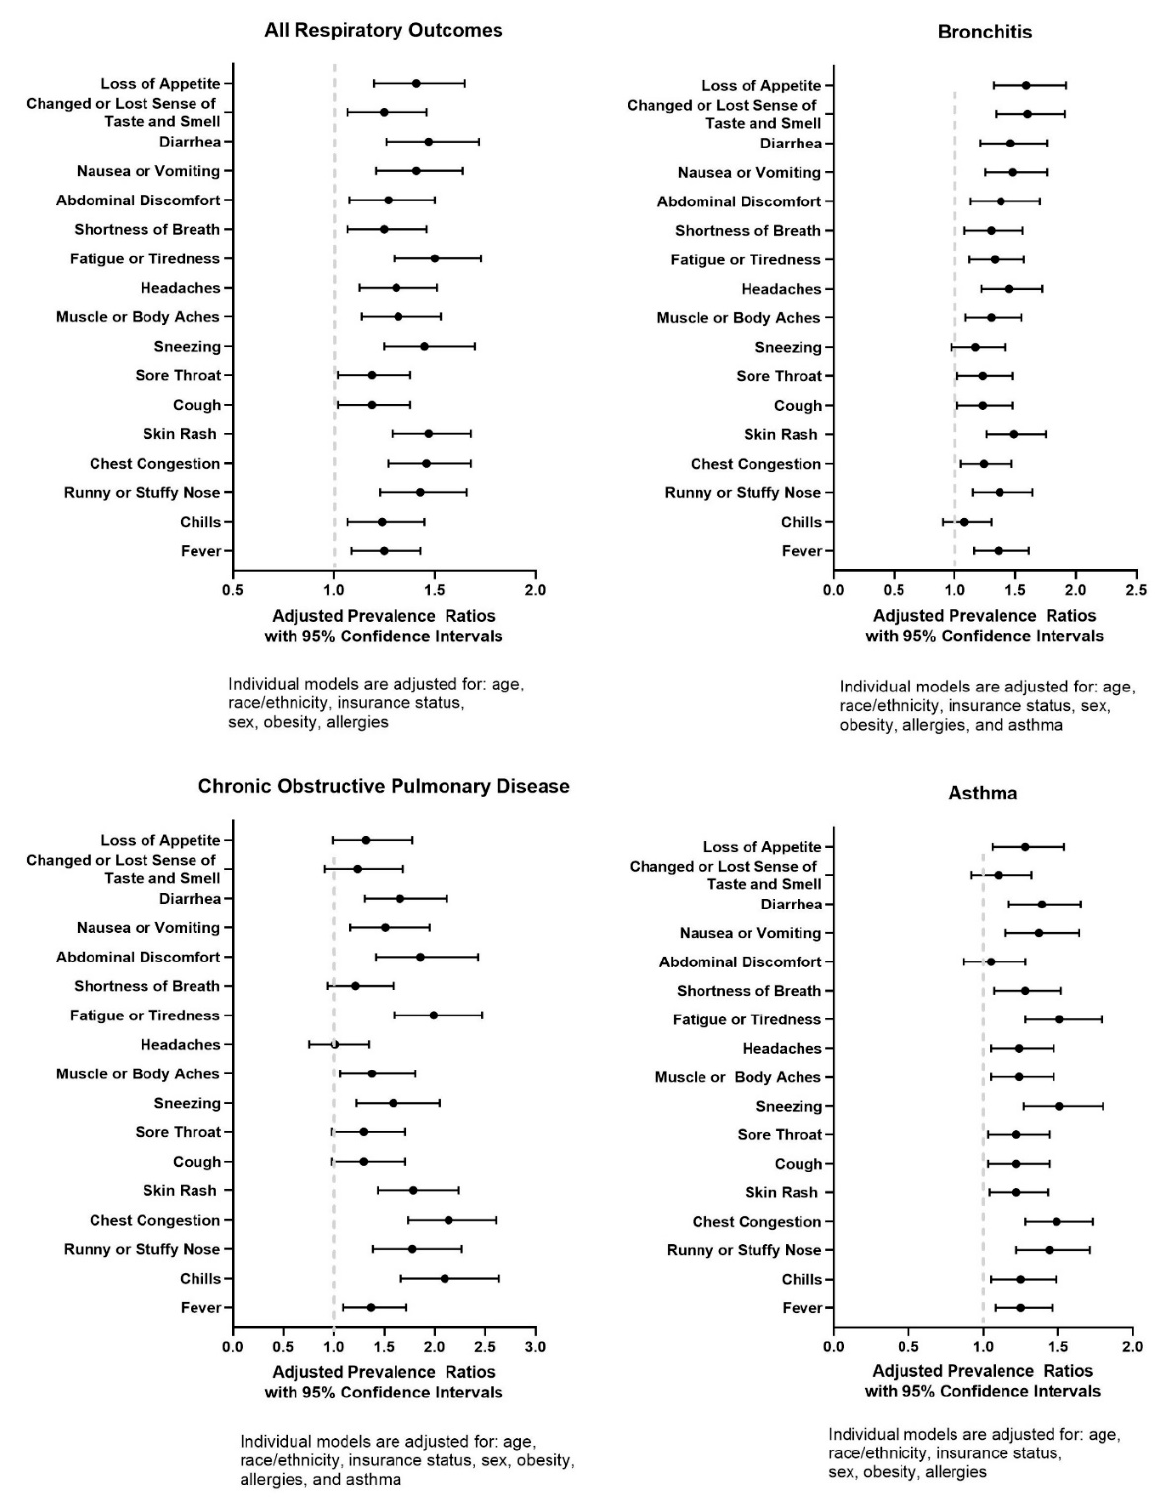
Figure 1. Associations of physical symptoms reported in the last 7 days among adults with respiratory conditions during the COVID-19 pandemic in the United States, derived from the COVID-19 Household Impact Survey (April–June 2020).